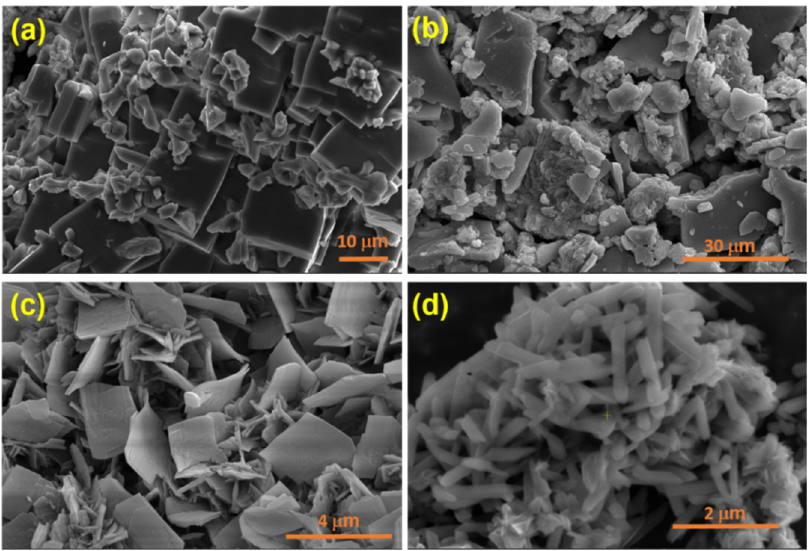
Figure 5. SEM micrographs of ( a ) MOF-5, ( b ) Co-MOF-5, ( c ) Ni-MOF-5, and ( d ) Fe-MOF-5.